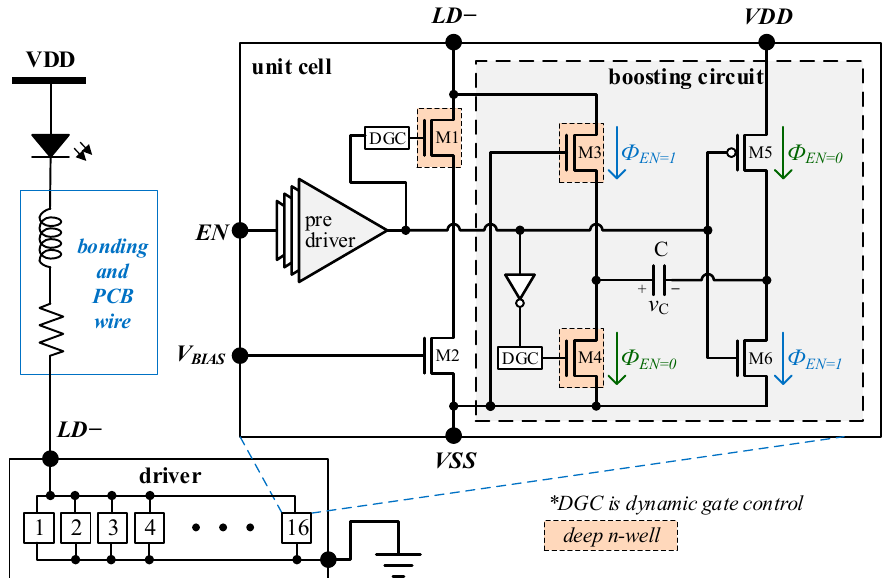
Figure 4. Proposed VCSEL driver with negative voltage boosting circuit.